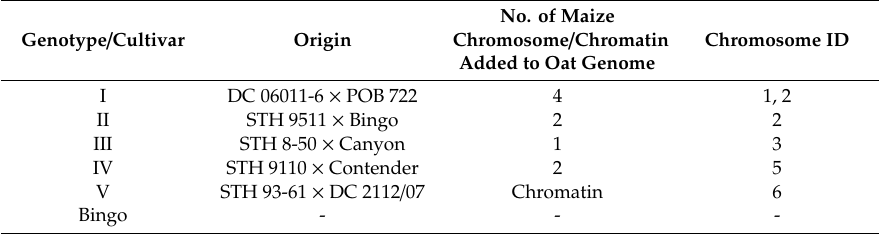
Figure 2. Visualization of added maize chromatin in oat genome by genomic in situ hybridization (GISH): ( A ) line I, ( B ) line II, ( C ) line III, ( D ) line IV, ( E ) line V, ( F ) cv. Bingo. Green fluorescence: maize total genomic DNA (gDNA); red fluorescence: 25S rDNA; blue fluorescence: DAPI. Yellow fluorescence is the result of colocalization of red and green signals and indicates the presence of highly conservative 35S rDNA sites, which are recognized by both maize gDNA and 25S rDNA probe. Scale bar: 5 µm. Table 1. Characteristics of the plant material used in the